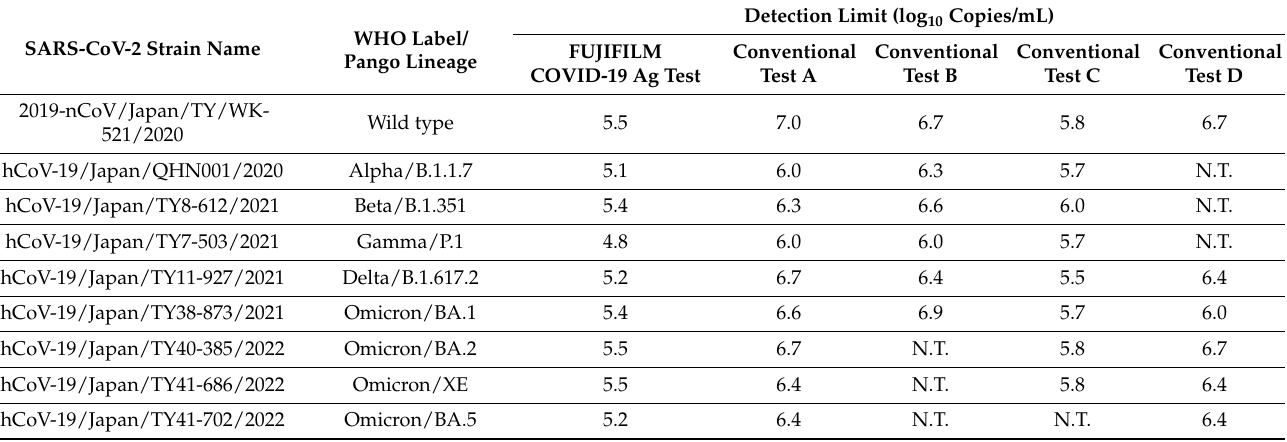
Table 1. Detection limits of the FUJIFILM COVID-19 Ag and conventional tests of isolated SARS- CoV-2